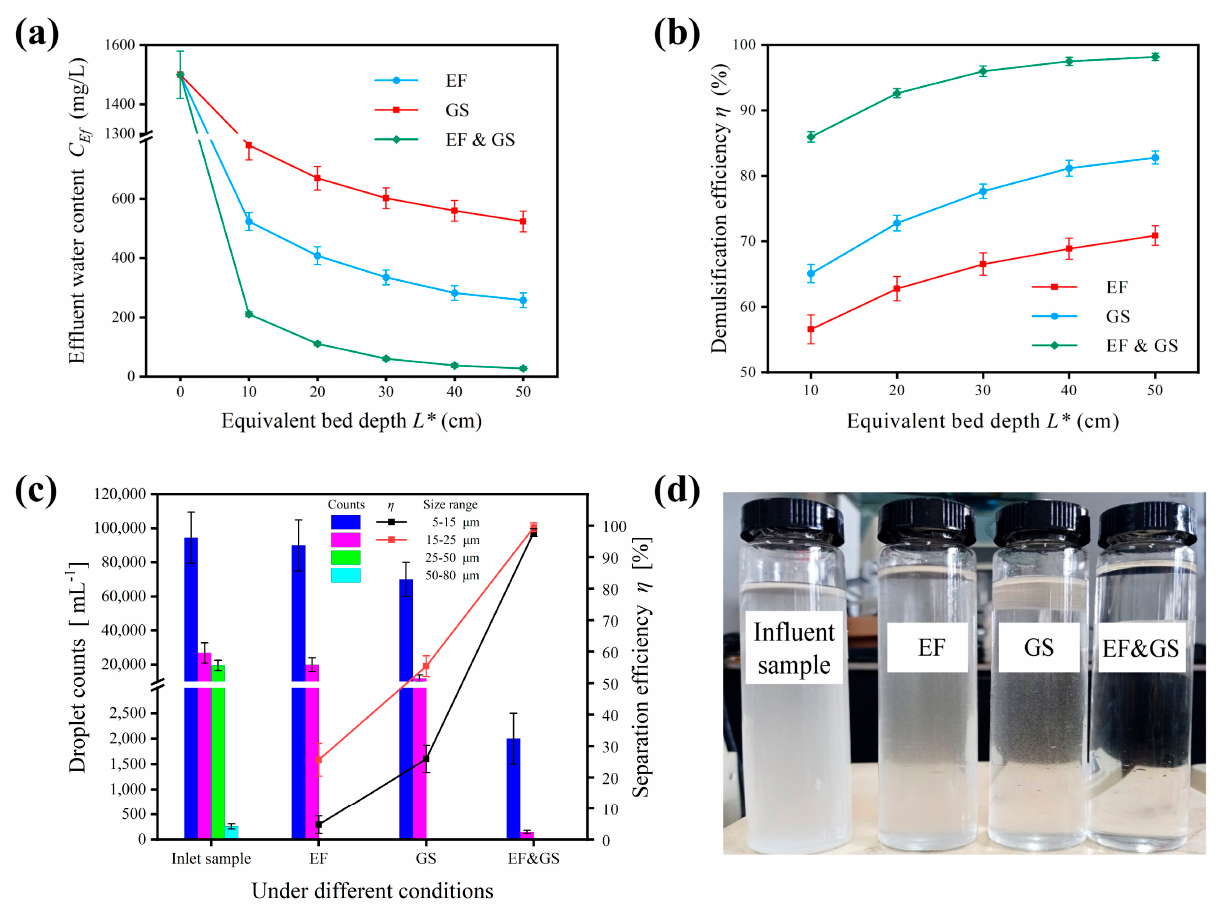
Figure 6. Comparison of separation effects under a DC electric field, medium coalescence, and the enhanced treatment. ( a ) Effluent water content. ( b ) Separation efficiency. ( c ) Separation effect of droplets of different sizes. ( d ) Sample photos (at L * = 50 cm). Conditions: C in = 1500 mg/L; v = 0.001 m/s; U = 3 kV or 0 kV; GS medium bed with size of 1.0–2.0 mm or no medium and L * = 10, 20, 30, 40, 50 cm.